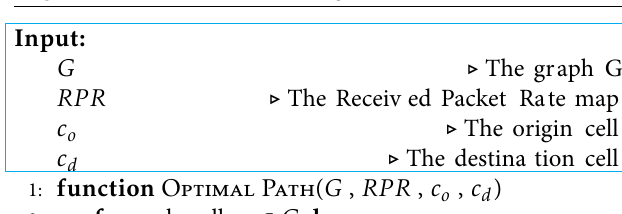
Algorithm 1 Optimal Path algorithm